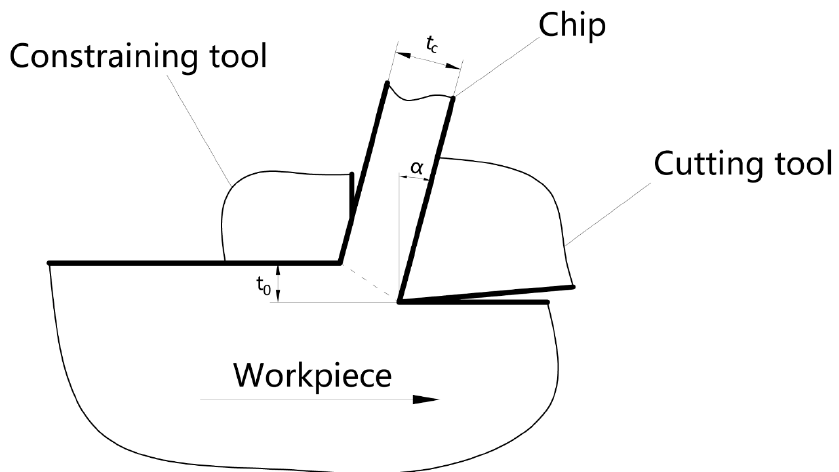
Figure 1. Large strain extrusion machining (LSEM) process.